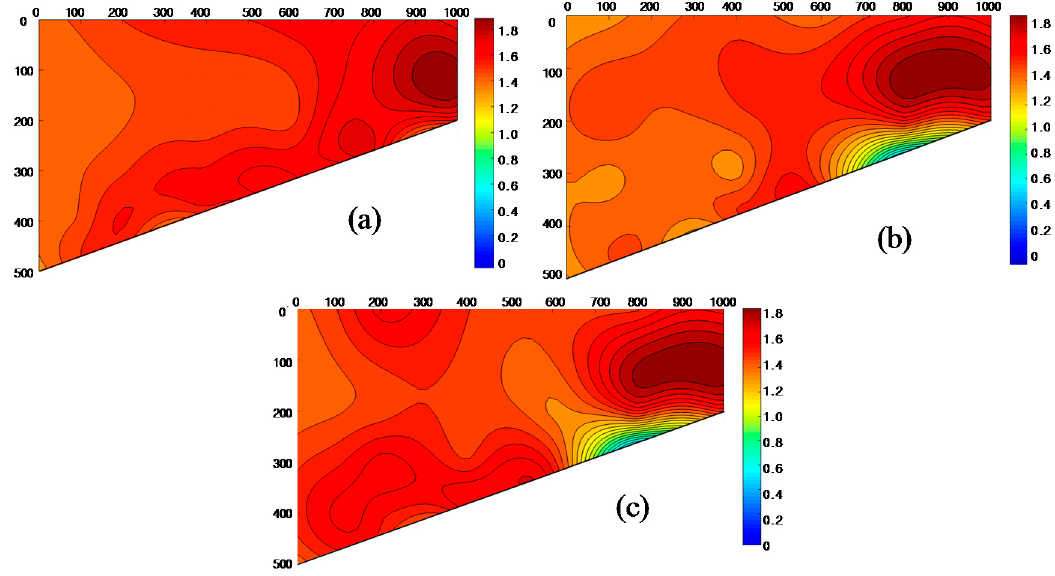
Figure 7. Effect of partition plate angle on the average density of particles in the bed. ( a ) θ = 25°; ( b ) θ = 35°; ( c ) θ = 45°.